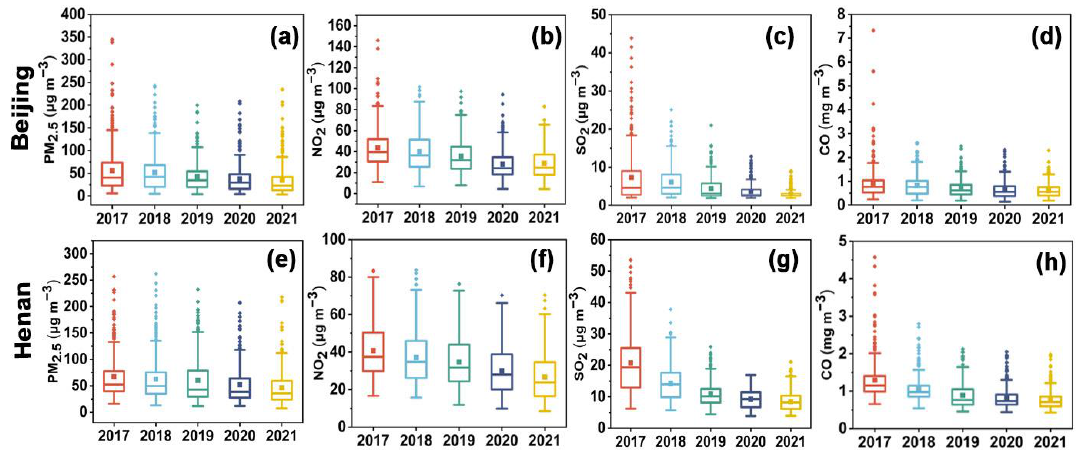
Figure 2. Yearly variations in the concentrations of PM 2.5 , NO 2 , SO 2 , and CO during 2017 – 2021 in Beijing and Henan. ( a – d ) show annual concentrations of PM 2.5 , NO 2 , SO 2 , and CO during 2017 – 2021 in Beijing, respectively, and ( e – h ) show annual concentrations of PM 2.5 , NO 2 , SO 2 , and CO during 2017 – 2021 in Henan, respectively.The box frames represent the upper and lower quartile, the line represents the median, the whiskers denote the range within 1.5IQR, the square point within the box frame represents the mean, and the points outside the box frame represent outliers.